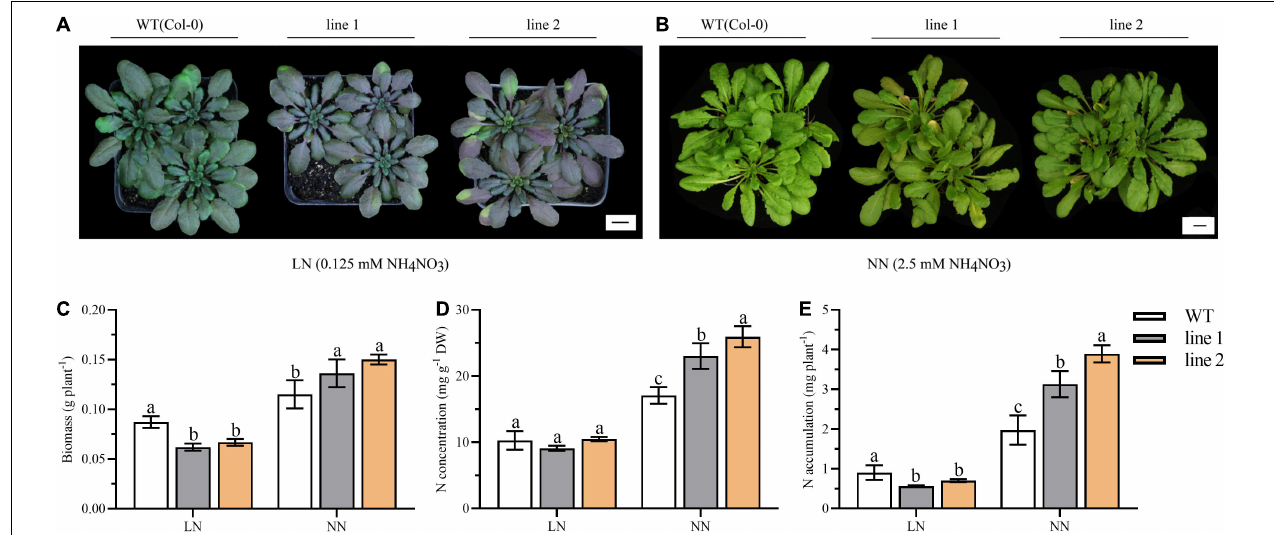
FIGURE 7 | Biomass, N accumulation and growth performance in soil for 9-week-old transgenic and wild type Arabidopsis theliana . Plants grown for 9 weeks under LN (A) or NN (B) conditions. Biomass (C) , N concentration (D) and N accumulation (E) of desiccated plants harvested at vegetative phase (9 weeks; n ≥ 5). Three biological replicates were performed. Data are means ± SD . Significant differences are indicated by letters (ANOVA; P ≤ 0.05). WT, wild type (Col-0), line 1 and line 2, two transgenic lines. LN, low nitrogen, 0.25 mM N (0.125 mM NH 4 NO 3 ); NN, normal nitrogen, 5 mM N (2.5 mM NH 4 NO 3 ).